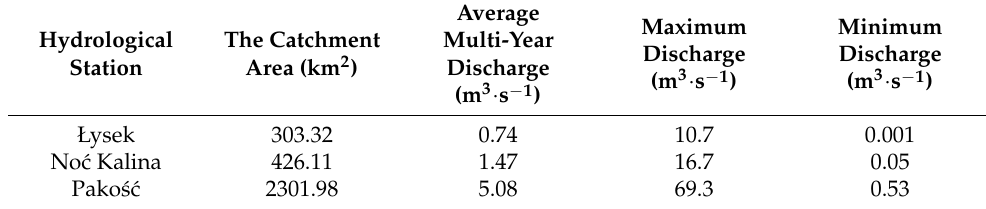
Table 2. Hydrological characteristics of the Note´c River in the period of 1980–2016—annual